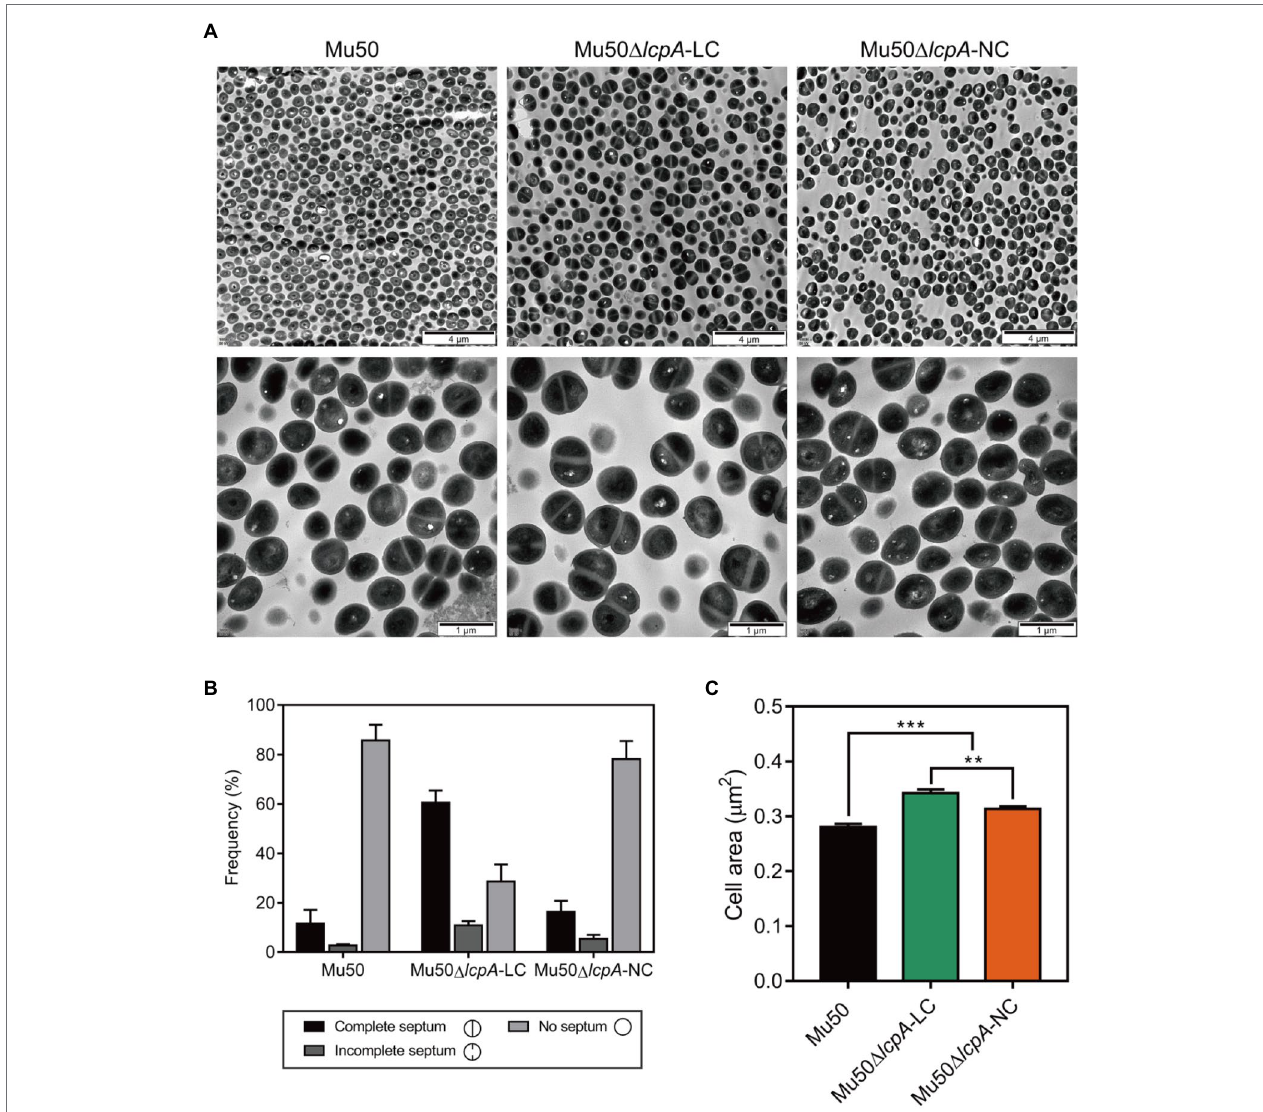
FIGURE 3 | TEM reveals cell septal morphology of Mu50 isogenic strains. (A) TEM images of wild-type Mu50, Mu50 ∆ lcpA -LC and Mu50 ∆ lcpA -NC in TSB to stationary phase at 37 ° C. The scale bar of the top row of images is 4 μ m, and the scale bar of the bottom row of images is 1 μ m. (B) To estimate the fraction of the cells with the complete septum, at least 400 cells were scored according to the septum growth. (C) To estimate the individual cell size, the cell area of 300 cells per strain was measured. Error bars correspond to SEM. One-way ANOVA with LSD test for multiple comparisons, * p < 0.05, ** p < 0.01, *** p <